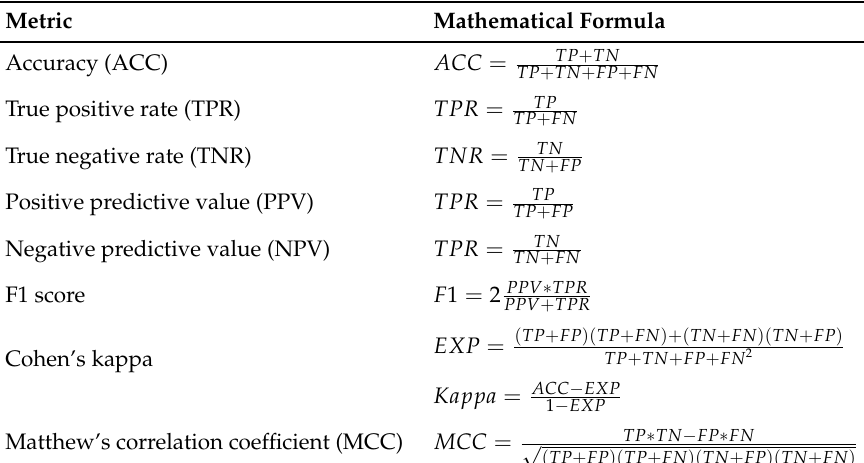
Figure 4. Confusion matrix and class label utilized in this study. Table 2. List of evaluation